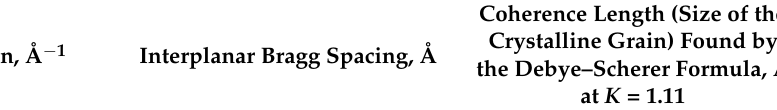
Coherence Length (Size of the Crystalline Grain) Found by the Debye–Scherer Formula, Å at K = 1.11